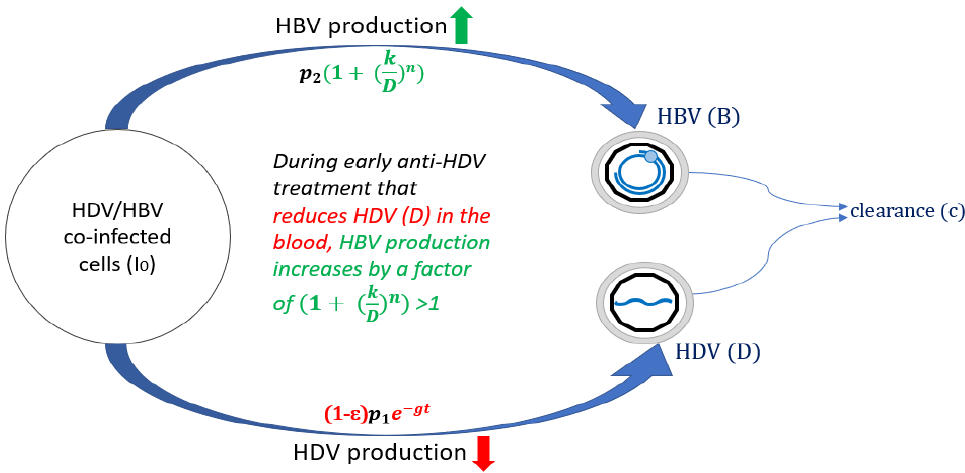
Figure 2. Schematic diagram for the modified model, Equations (1) and (5).